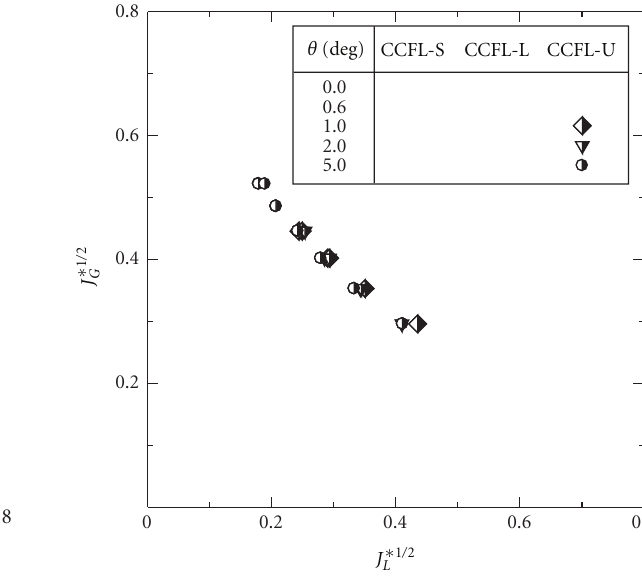
Figure 8: CCFL-S characteristics (e ff ects of θ ).